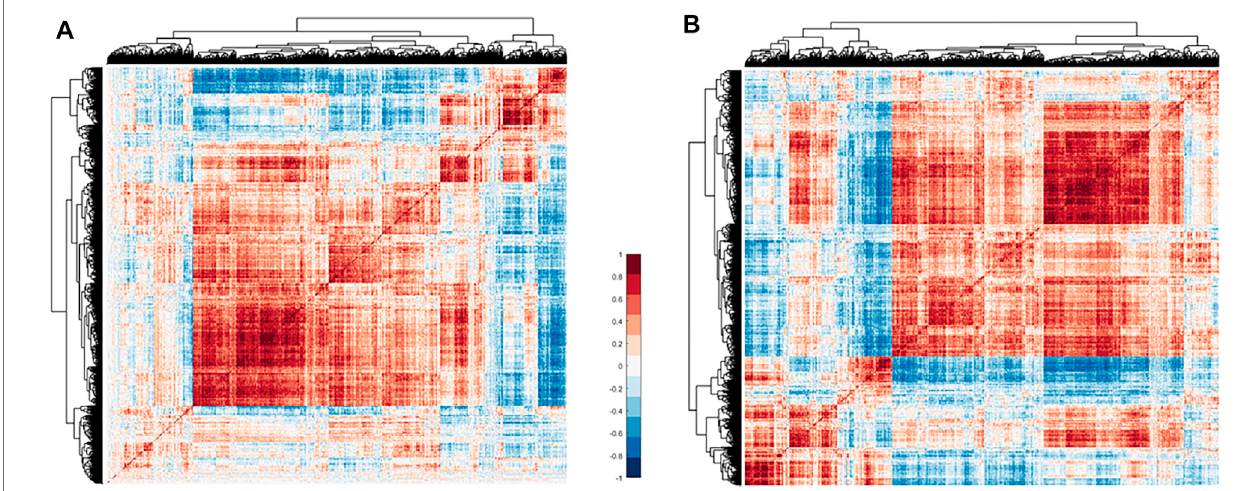
FIGURE 2 | Heat map ofimmune gene correlation matrix clustering. (A) Correlation matrix clustering hot map of2,247 immune genes in TCGA thymoma data. (B) The2,023immunegenecorrelationmatrixclusteringheatmap.Ofthese,224noisegenesareeliminatedbythecorrelationmethod.Redmeanspositivecorrelation,blue means negative correlation, and white means no correlation.